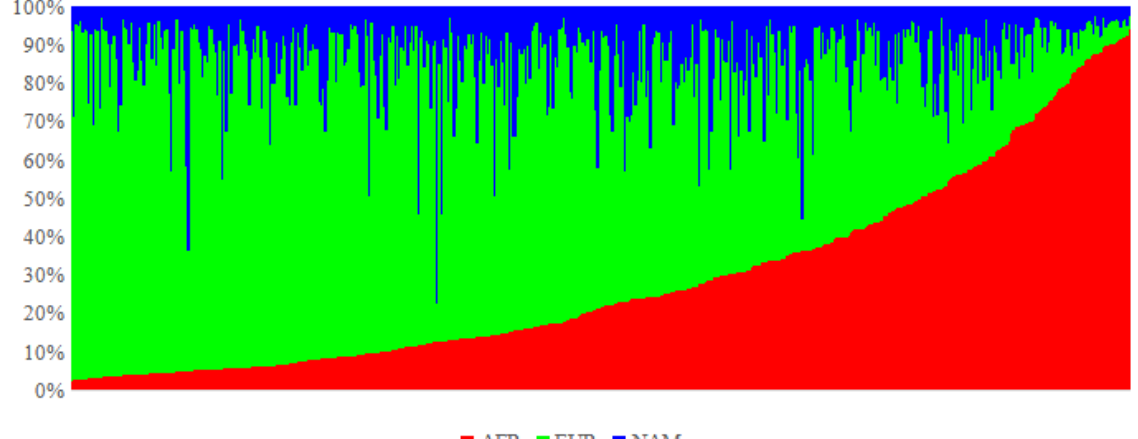
Figure 1. Genomic ancestry estimates of each individual in the population sample of the State of Rio de Janeiro. The average genomic ancestry values in the sample were 28.8% African, 57.2% European, and 14% Native American. Each column represents an individual and each color represents the corresponding relative ancestry proportion in relation to a reference population. The analyses were carried out using reference population (option USEPOPINFO in STRUCTURE), and considering K =